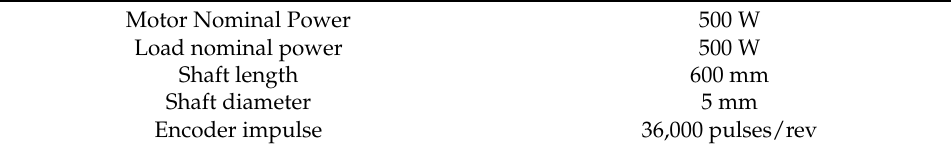
Table 4. Parameters of the experimental setup.